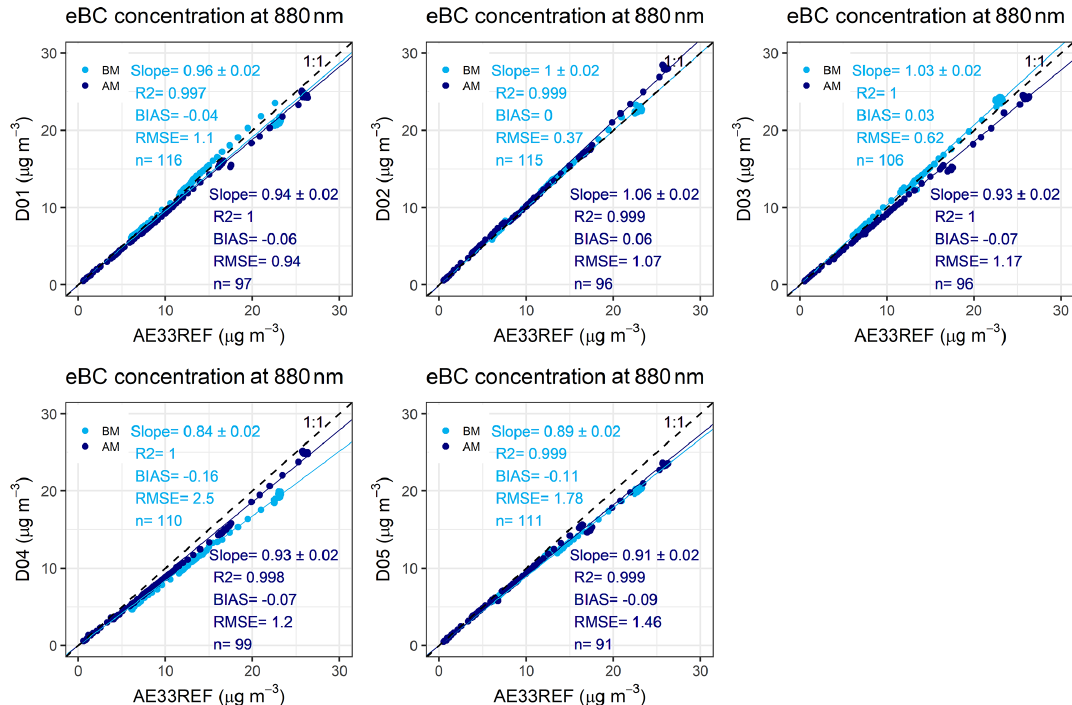
Figure 9. Regression for the comparison of the instruments in group D and the reference Aethalometer before and after maintenance during soot measurements. The intercept was forced through zero. BM: before maintenance. AM: after maintenance.